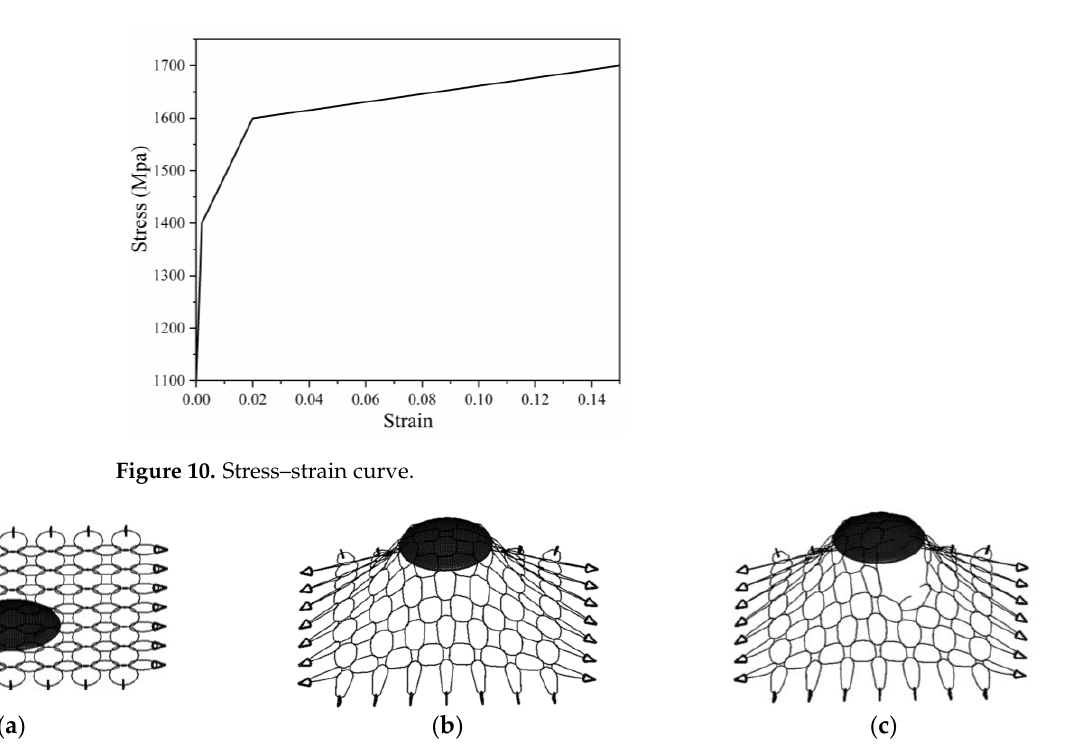
Figure 11. Ring net deformation process in the static punching test: ( a ) ring net relaxation state; ( b ) ring net deformation; ( c ) ring net breakage.